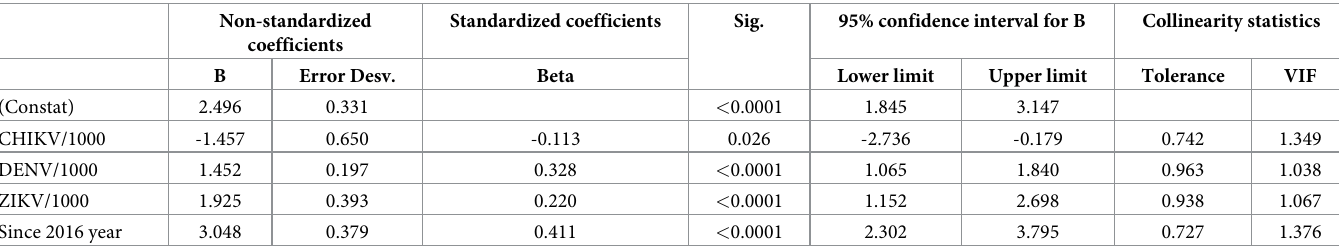
Table 2. Interrupted time series analysis, segmented linear regression of GBS cases and arboviruses cases,